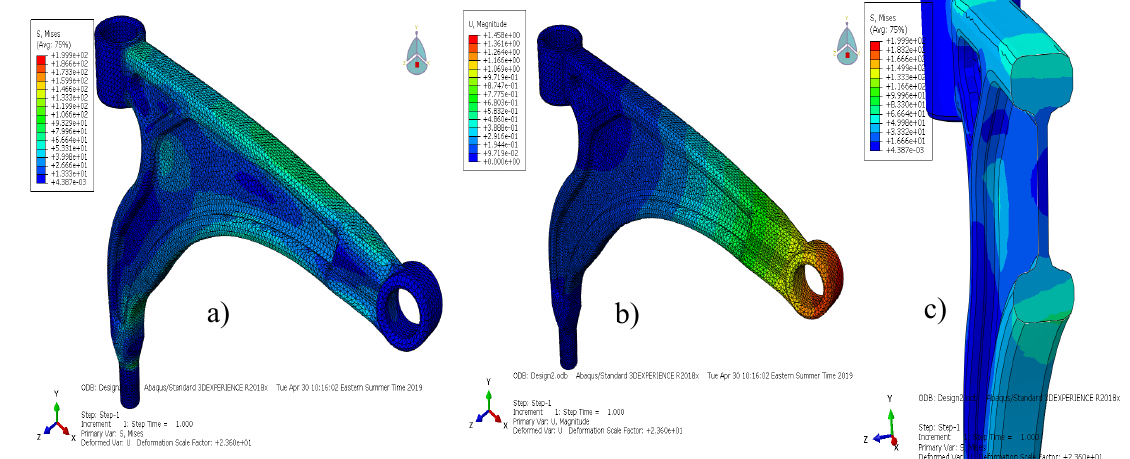
Figure 8. FEA of planar thin web design; ( a ) von Mises stress plot, ( b ) total displacement plot, ( c ) cross-sectional stress distribution.